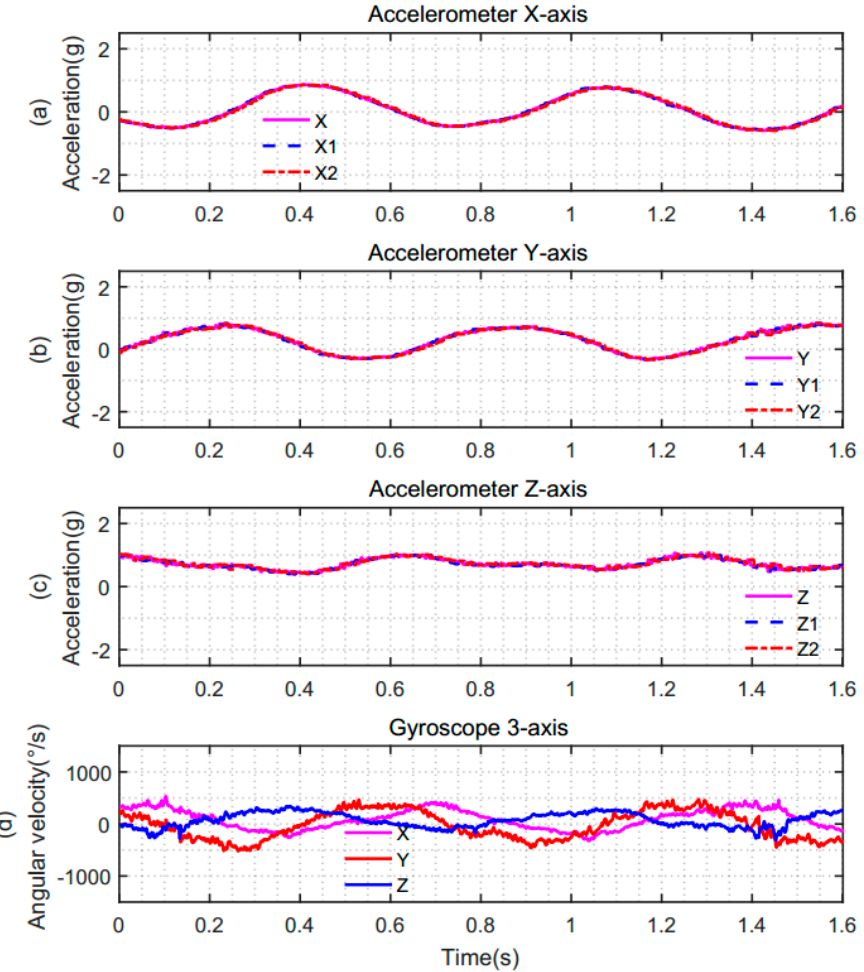
Figure 11. The data of the accelerometer and gyroscope. ( a ) X -axis data of the accelerometer; ( b ) Y -axis data of the accelerometer; ( c ) Z -axis data of the accelerometer; ( d ) three-axis data of the gyroscope.